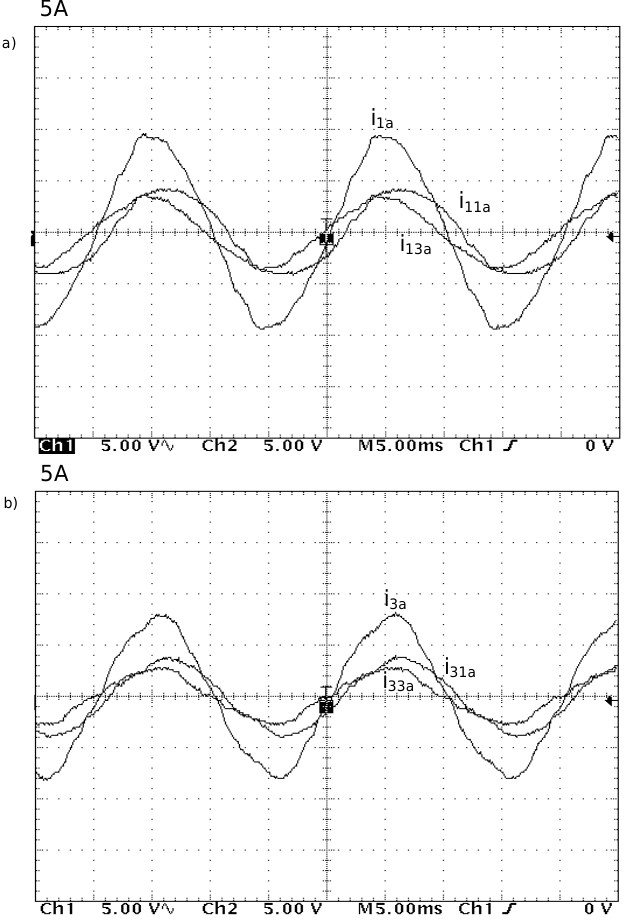
Figure 25. Oscillograms: Winding currents of 3CRλ1; i 1 a , i 11 a , i 13 a ( a ) and 3CRλ3; i 3 a , i 31 a , i 33 a ( b ).